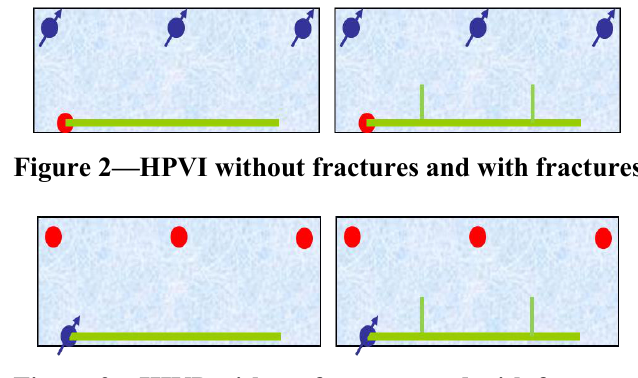
Figure 3—HIVP without fractures and with